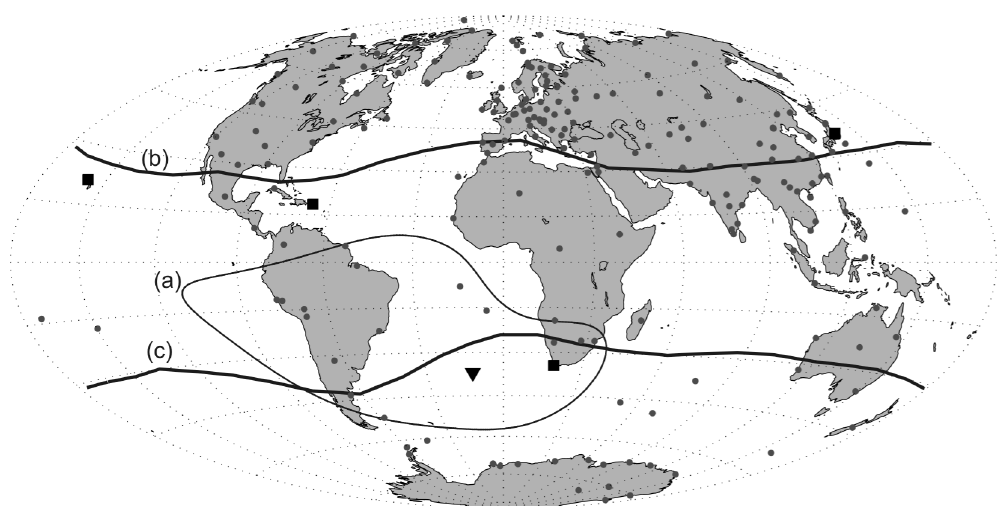
Fig. 1. Global distribution of geomagnetic observatories for 2008 (dots) and location of Tristan da Cunha (tri- angle). The South Atlantic Anomaly (SAA) is indicated by the 30000 nT isoline (a) for total field strength cal- culated after the CHAOS model (Olsen et al ., 2006). The northern (b) and southern (c) track of the solar quiet (Sq) current system foci are indicated as lines (computed from CM4, Sabaka et al ., 2004). The four Dst-obser- vatories are shown by